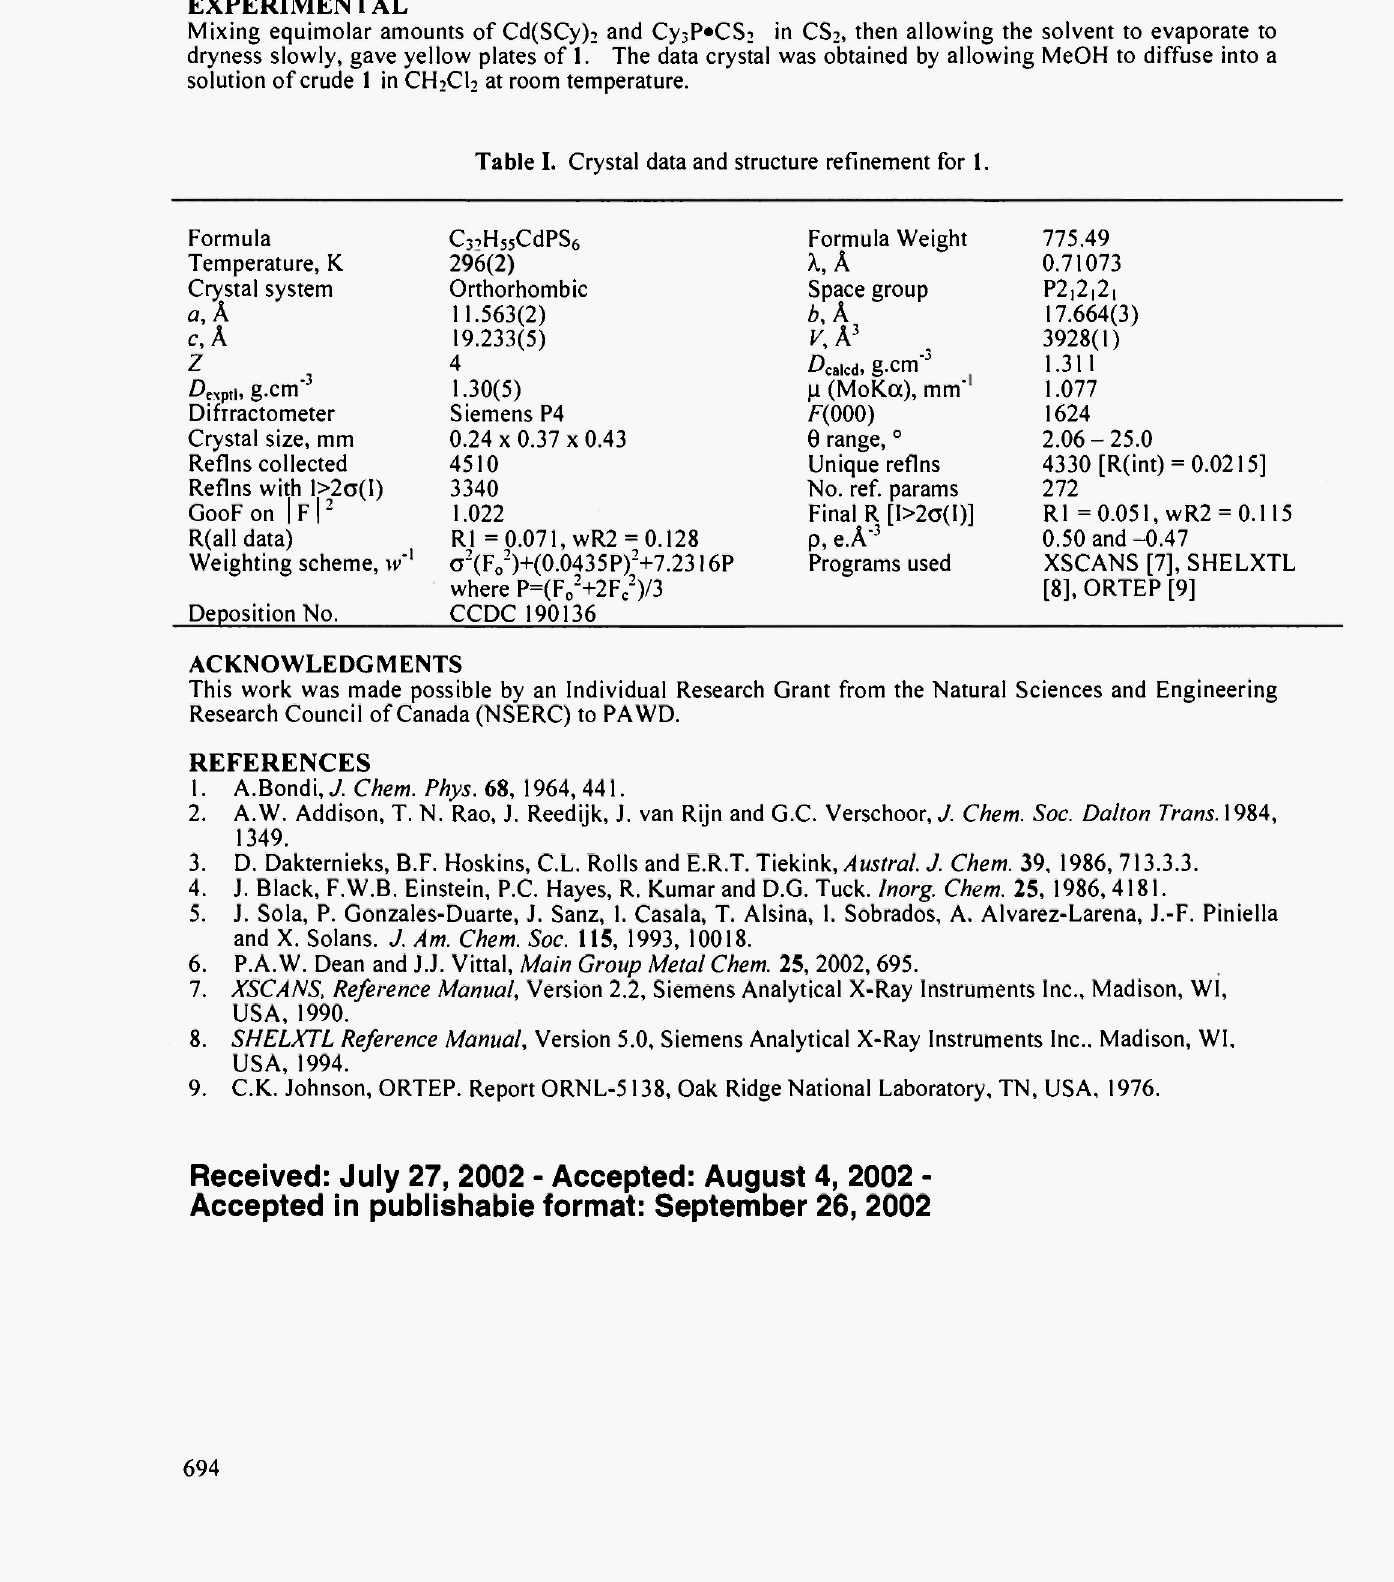
Table I. Crystal data and structure refinement for